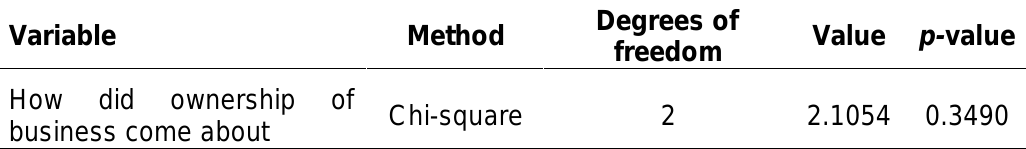
Table 12: Significant Differences Relating to How Ownership Came About